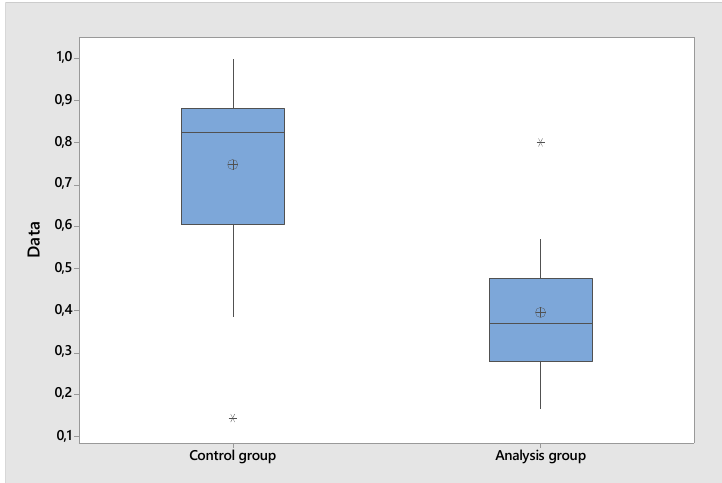
Figure 6. Boxplot of the fraction of valid, operational, and non-redundant requirements produced by each subject.